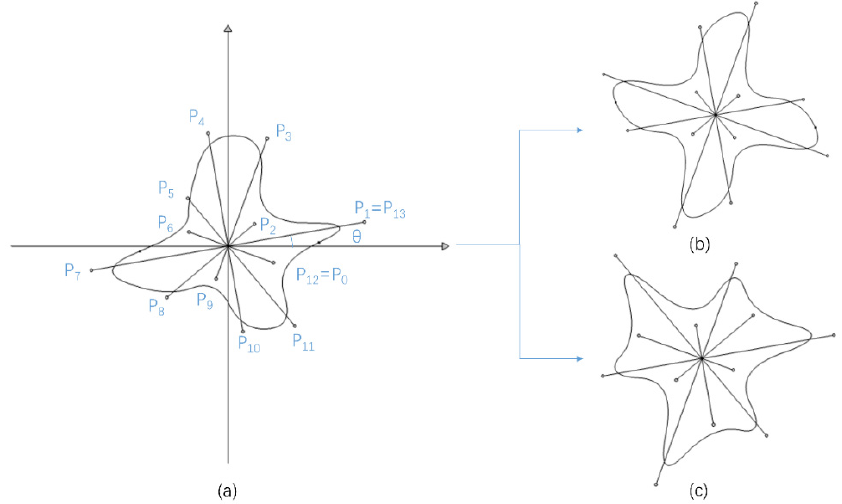
Figure 1. ( a ) An illustration of the potential scatter described by a B-spline curve with 14 control points. ( b ) A C 4 -symmetric design with reduced independent pa- rameters, i.e., r i = r i + 3 = r i + 6 = r i + 9 ( i = 1,2,3 ) . ( c ) A C3-symmetric design with constraints r i = r i + 4 = r i + 8 ( i = 1, 2, 3, 4 ) .